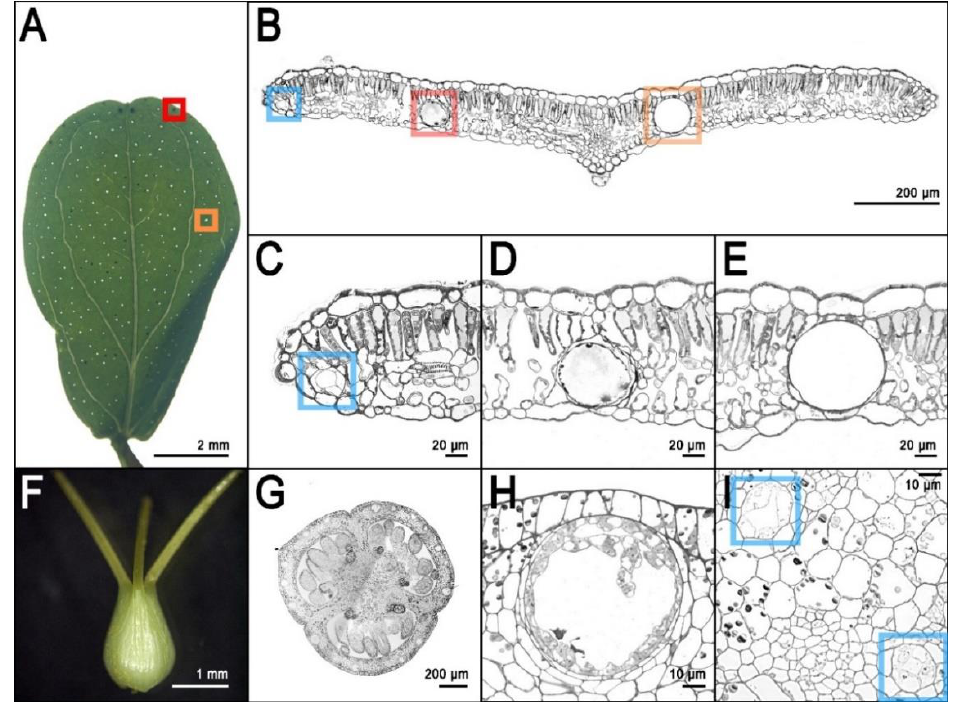
Figure 2. Secretory structures of Hypericum perforatum. ( A ): Adult leaf in backlight showing dark glands (red square) and pale glands (orange square); ( B ): Cross section of an adult leaf showing one pale gland (orange square), one dark gland (red square) and a type c secretory canal (blue square); ( C ): Detail of the type C canal from photo B ( D ): Detail of dark gland from photo B; ( E ): Detail of pale gland from photo B; ( F ): Pistil from open flower (external view); ( G ): Cross section of a pistil from an open flower showing dark glands growing on the placental tissue and type C secretory canals in the external portion of every carpel; ( H ): Detail of a type C canal from photo G; ( I ): Detail of type A canals from the placental tissue in photo G. Photos by Twan Rutten and Paride